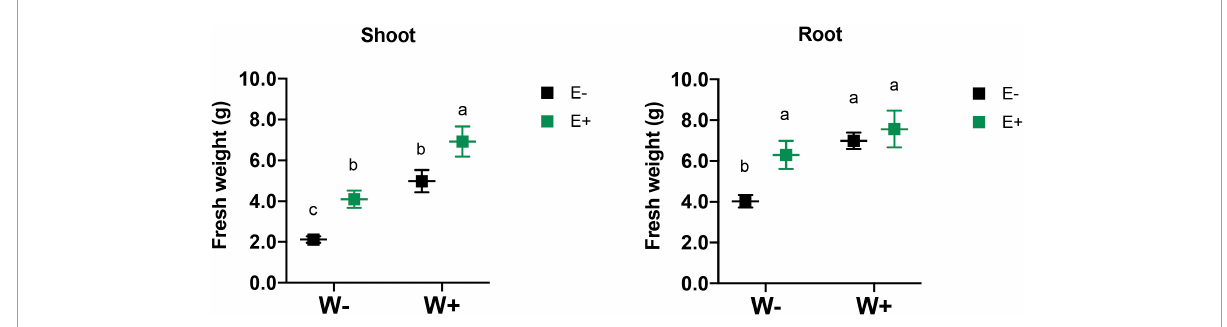
FIGURE2 Effect of drought stress and fungal inoculation on shoot and root biomass production of inoculated and non-inoculated strawberry plants Different letters indicate significant differences ( P < 0.05; two-way ANOVA). Bars represent means ± SE from three independent experiments.